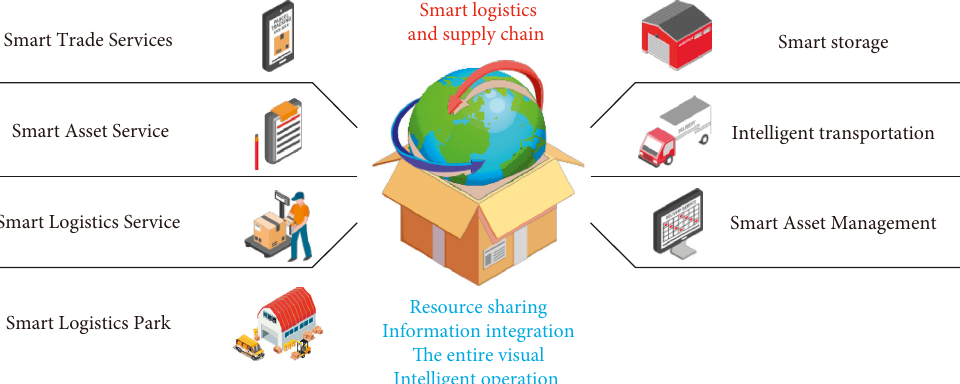
Figure 1: Analysis of development environment and upgrading mode of smart